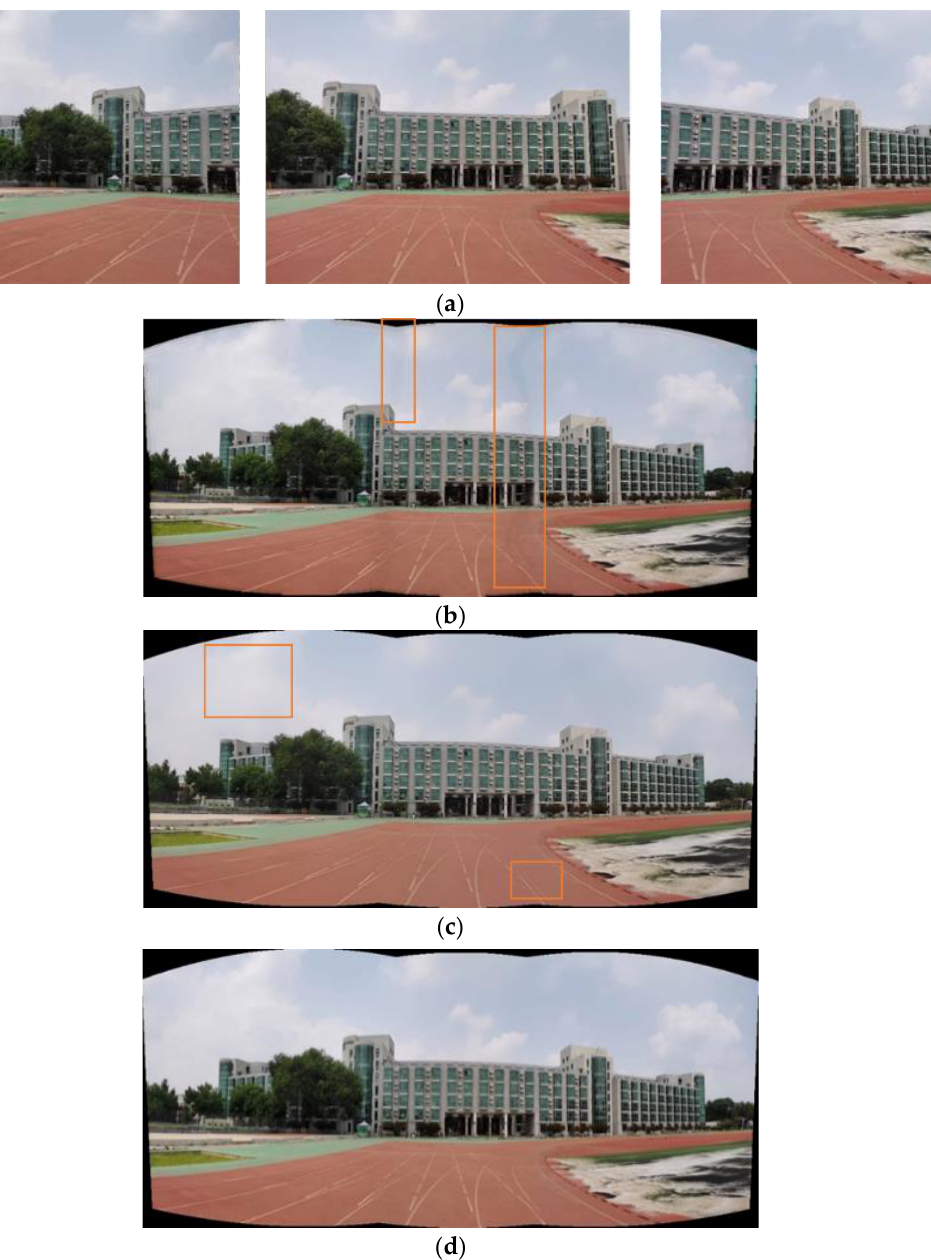
Figure 12. Building images: ( a ) input images; ( b ) panorama by optimal seam + fade-in and fade-out weighted method; ( c ) panorama by optimal seam + multi-resolution method; ( d ) panorama by proposed method.